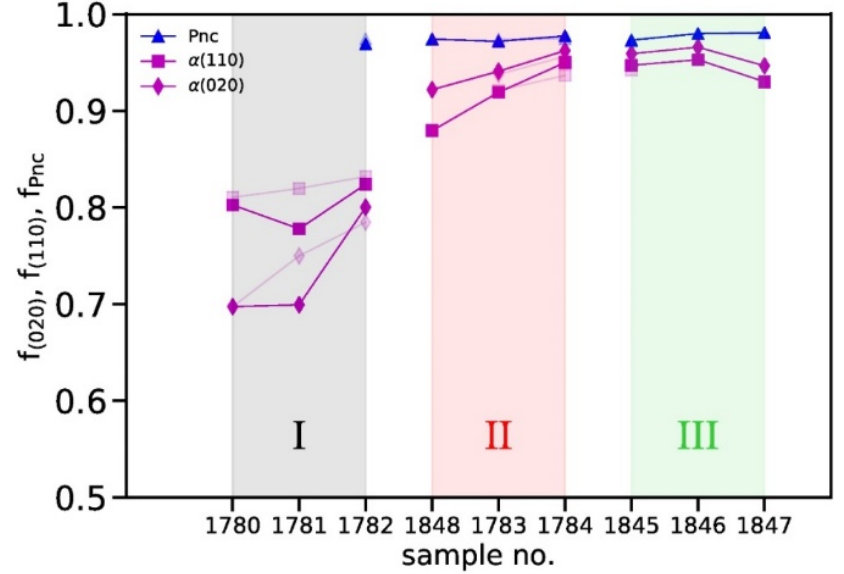
Figure 11. Hermans’ orientation factors as a function of the sample number for 33 months aged fibers. Shaded areas highlight the polymer grades I, II and III. Orientation factors extracted from WAXD patterns measured directly after spinning are shown with a faded color.